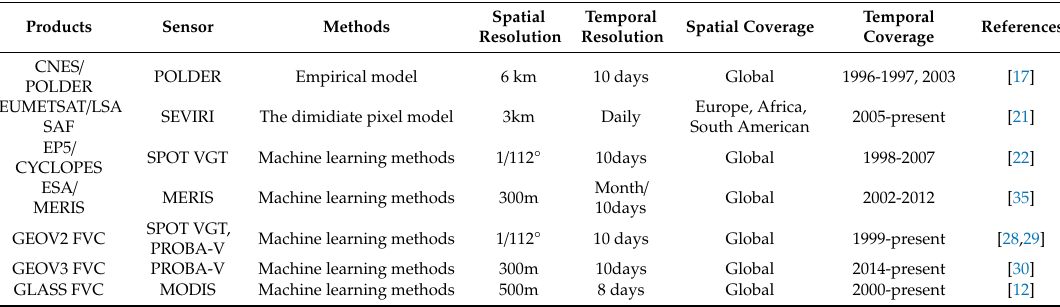
Table 1. The major fractional vegetation cover (FVC) products and their characteristics